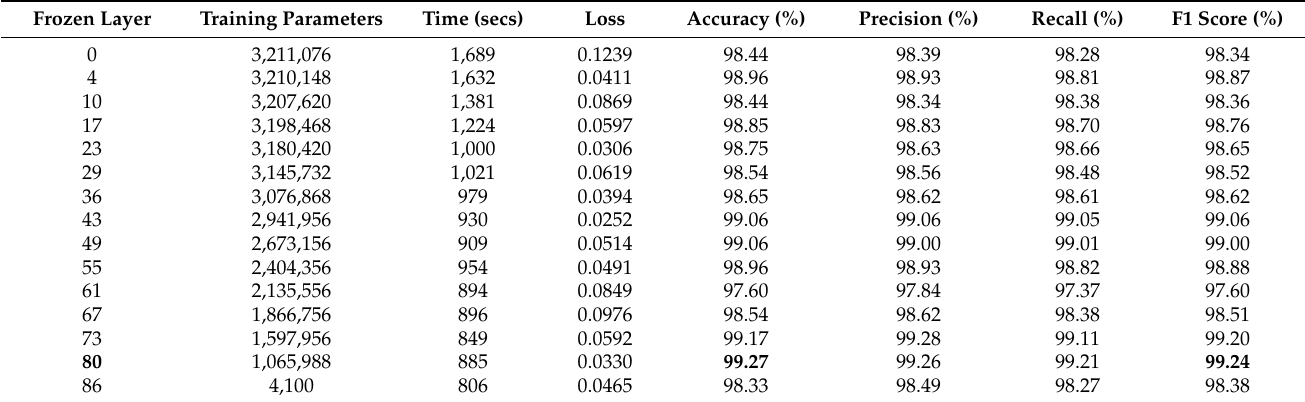
Table 5. Test results correspond to different frozen layers.